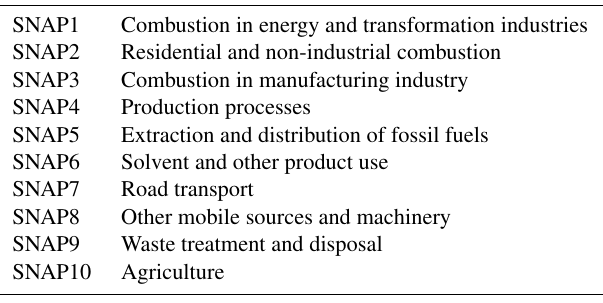
Table 1. SNAP source sectors as specified in the emissions input to the model (CEIP, 2015).